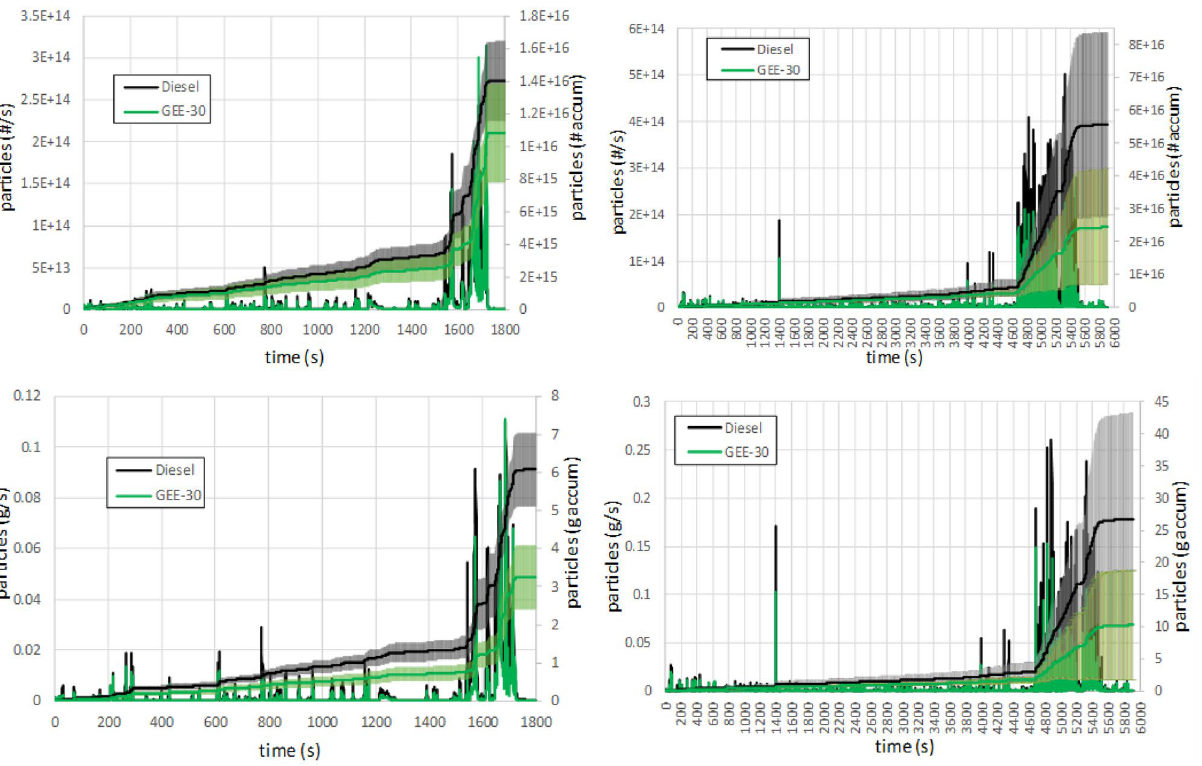
Figure 10. Instantaneous and accumulated particle number (above) and mass (below) emissions along WLTC (left) and along RDE (right).